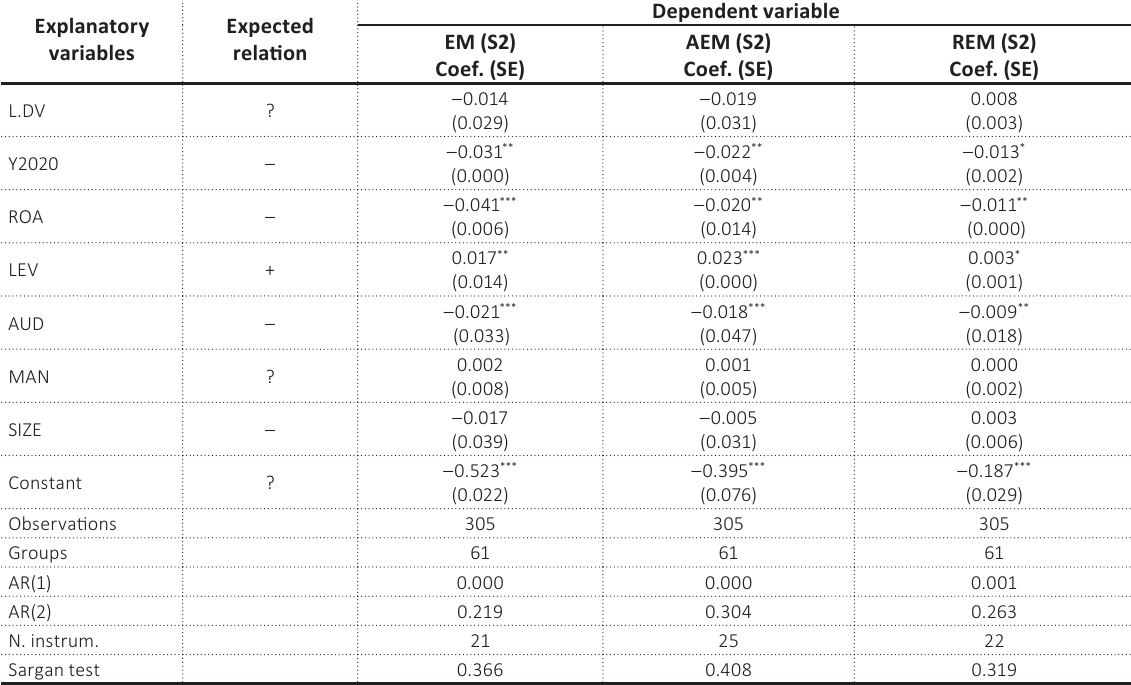
Table 4. Model (M1) estimate